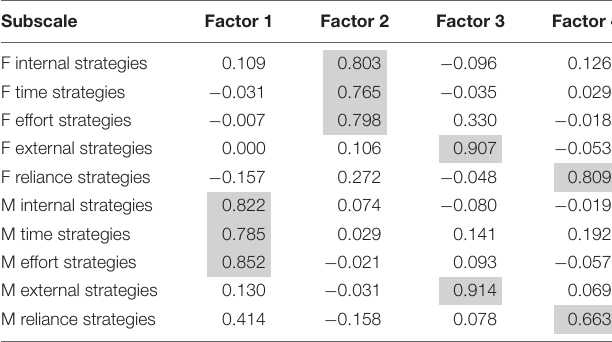
TABLE 3 | Factor loadings for wives’ (F) and husbands’ (M) compensation strategies, analysed at the couple